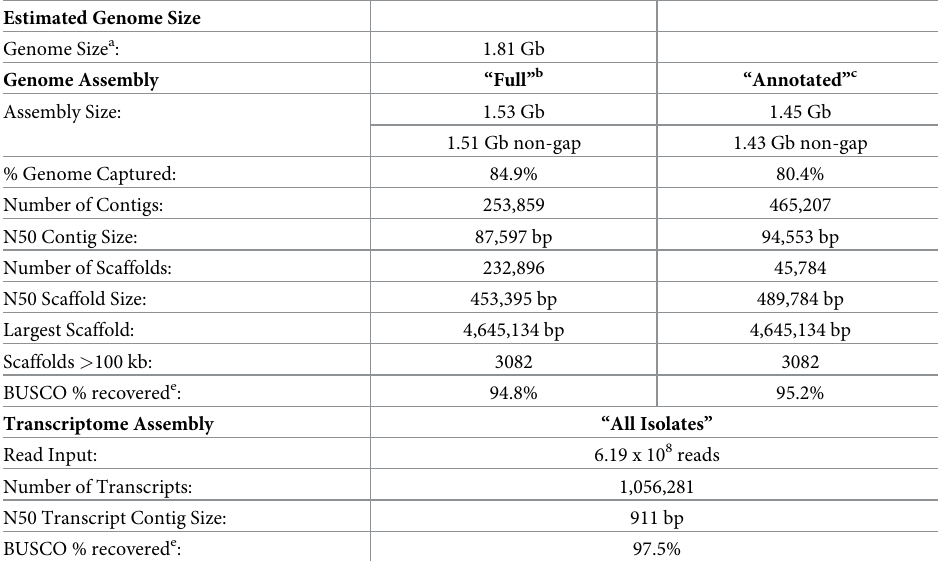
Table 1. Summary statistics for the C . darwini genome and transcriptome assemblies. Estimated Genome